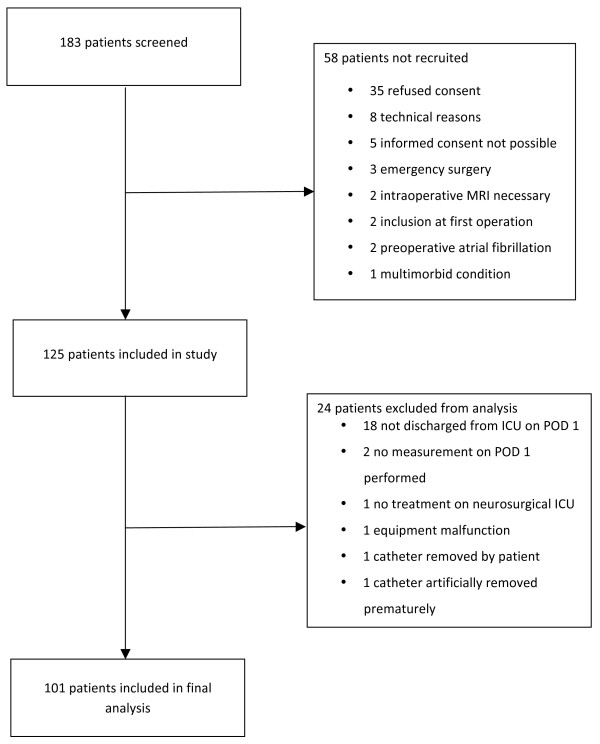
Flow of patient recruitment. ICU = intensive care unit; MRI = magnetic resonance imaging; POD = postoperative day.